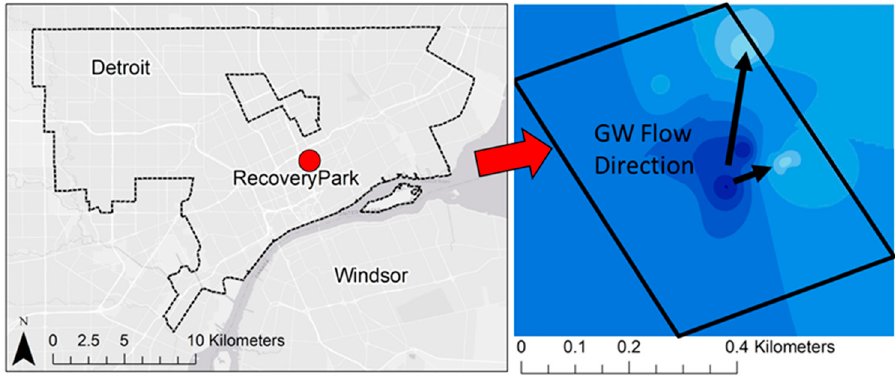
Figure 4. Local flow features of shallow groundwater in Recovery Park, Detroit. Flow rate is directed towards the north/northeast.